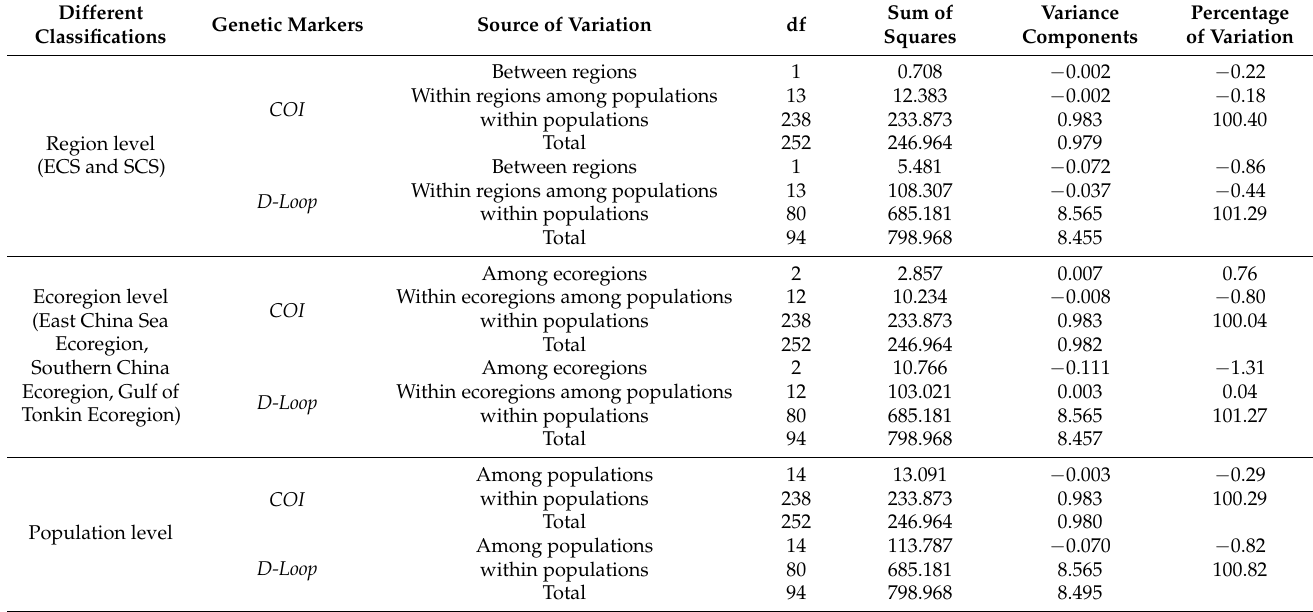
Table 3. AMOVA results of horn-eyed ghost crab based on COI and D-Loop